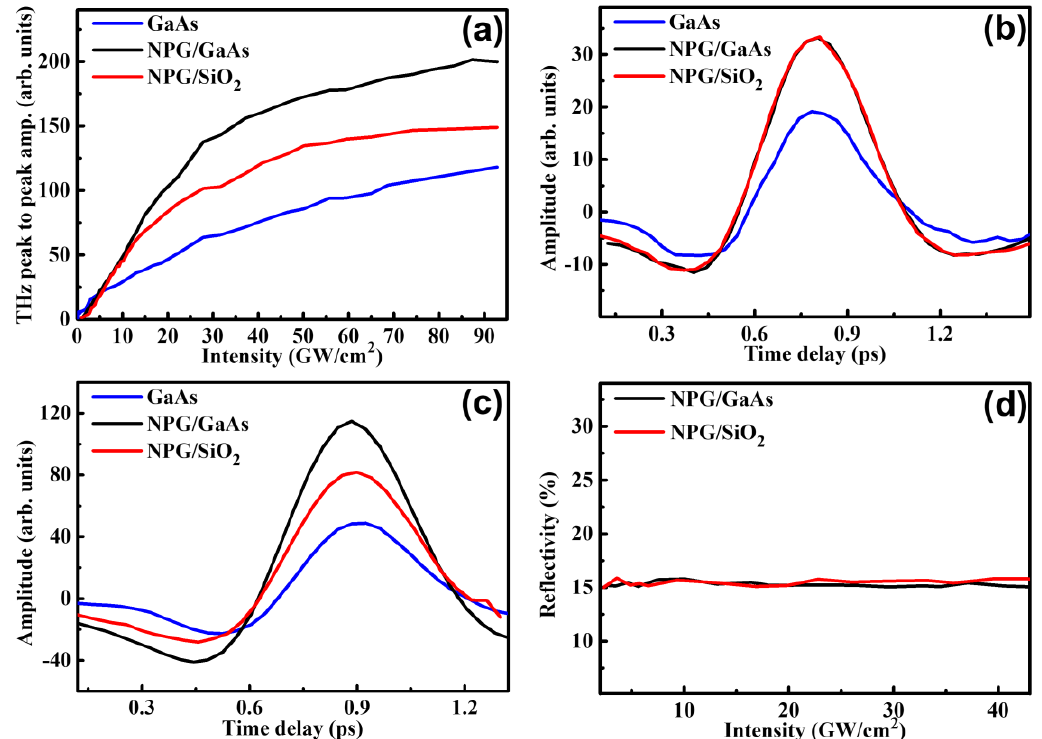
Figure 2. ( a ) Measured peak-to-peak amplitudes of far-field THz radiation plotted as a function of optical intensity of the incident femtosecond laser. Three different samples were used: NPG/SiO 2 (red curve), intrinsic GaAs without NPG films (blue curve) and NPG/GaAs (black curve); THz waveforms measured with the intensity at ( b ) 9.28 GW/cm 2 and ( c ) 37.14 GW/cm 2 ; ( d ) The reflection of 800 nm light from the NPG films deposited on glass (red curve) and GaAs (black curve) as a function of the peak intensity of the incident femtosecond laser.